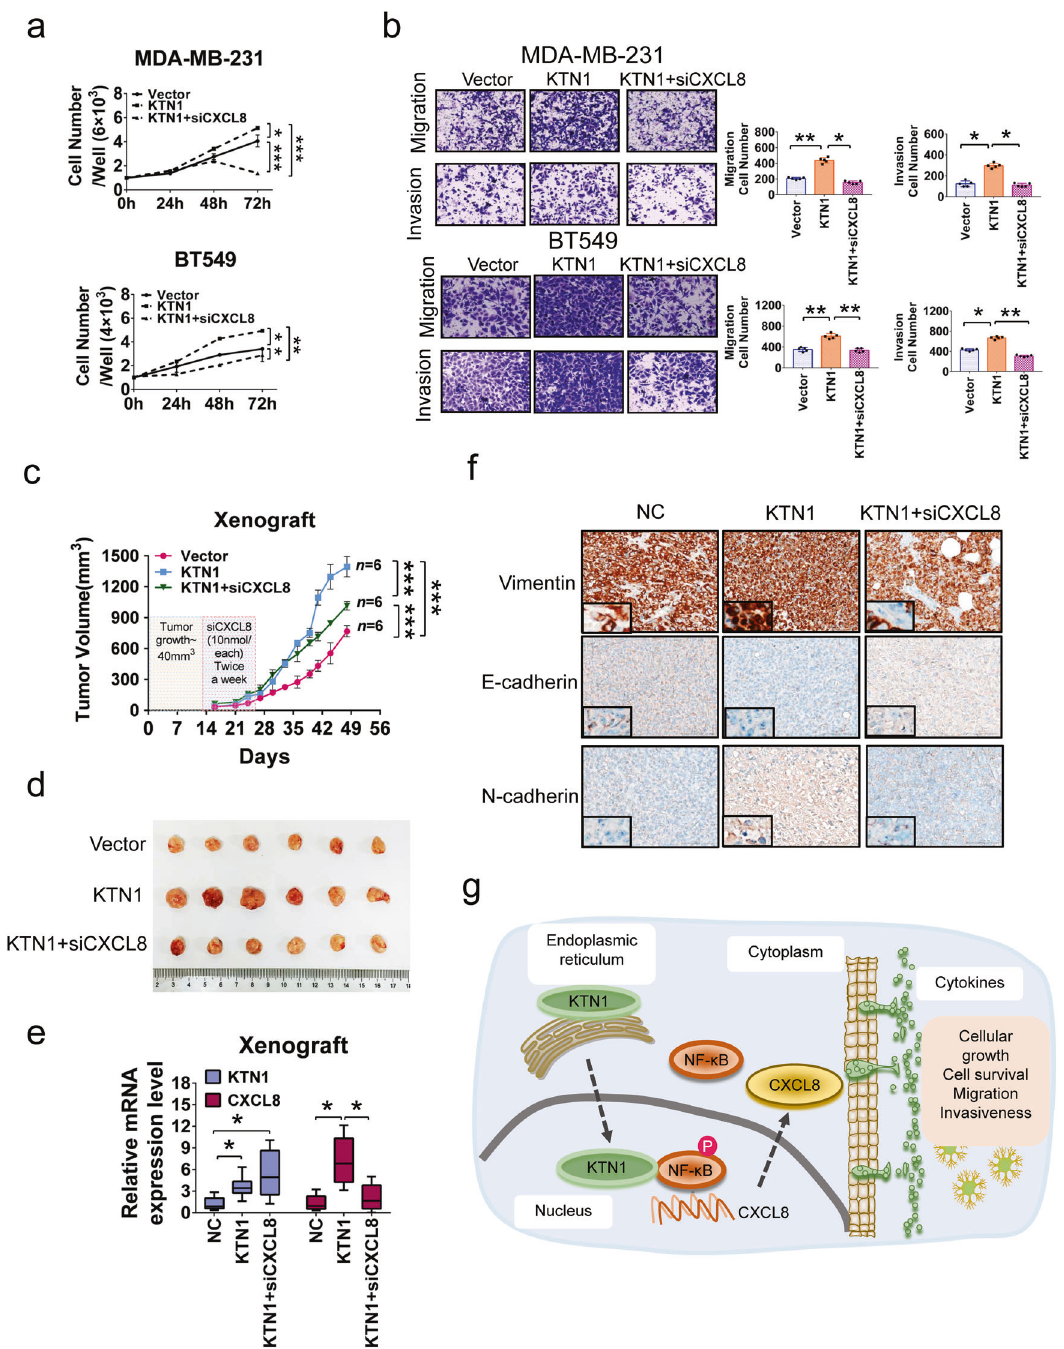
Fig. 6 KTN1 was required to promote TNBC tumorigenesis both in vitro and in vivo. a CCK-8 assay on cell viability in KTN1 overexpressed MDA-MB-231 and BT549 cells transfected with CXCL8 siRNA oligos. b Migration and invasiveness of KTN1 overexpressed MDA-MB-231 and BT549 cells transfected with CXCL8 siRNA oligos determined by Transwell assays. c Tumor growth curves show the development of xenograft of MDA-MB-231 cells transfected with KTN1 overexpression or CXCL8 siRNA oligos. d The NSG mice were sacri fi ced at the end of the experiment and the dissected tumors were photographed ( n = 6). e QRT-PCR analysis of the mRNA expression of KTN1 and CXCL8 in xenograft tumors ( n = 6). f Representative images showed the effect of KTN1 overexpression or CXCL8 siRNA oligos on EMT in xenograft. g A schematic model of the KTN1-NF- κ B-p65-CXCL8-regulatory axis in TNBC development and progression. One-Way ANOVA and Dunnett ’ s multiple comparison test were used to analyze the data (* P < 0.05, ** P < 0.01, *** P < 0.001). Scale bars, 100 interacts with kinesin protein for the microtubule-based organelle Hence, it is essential to comprehensively exploit the molecular transport. 3 The kinesin-binding domain on KTN1 is located at the mechanisms involved in TNBC progression and identify reliable prognostic targets. COOH terminus and promotes the microtubule-mediated kinesin- Itaru Toyoshima fi rst found that the KTN1 protein of the ATPase activity. It was suggested that KTN1 was referred to be endoplasmic reticulum (ER) is a membrane receptor which involved in the regulation of the organelles. 29 Besides, KTN1 was